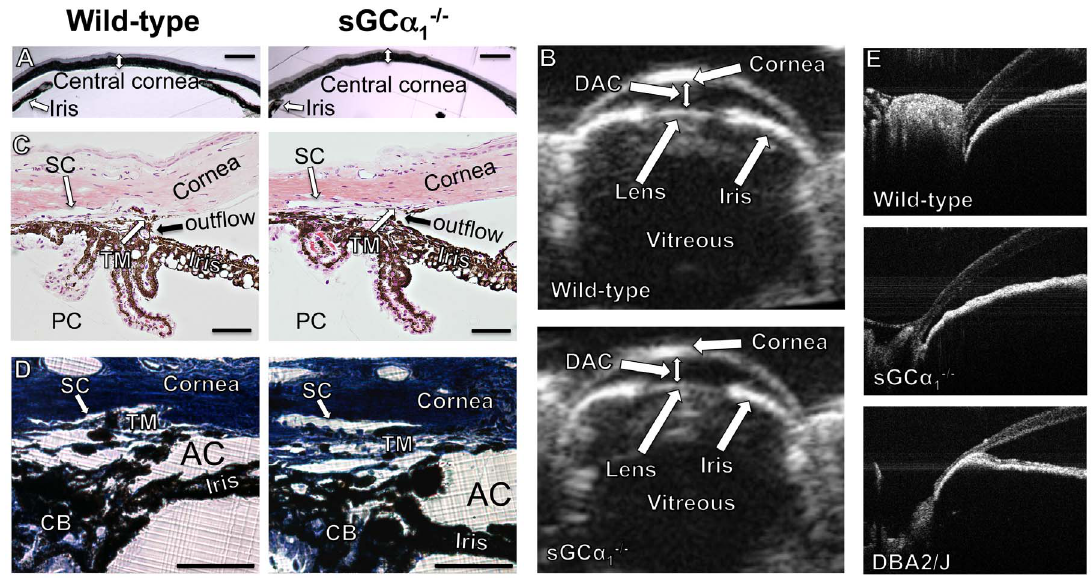
Figure 4. Morphology of the cornea and anterior segment does not differ in WT and sGC a 1 2 / 2 mice. A : Representative light microscopic images of the central cornea in wild-type (WT, left) and soluble guanylate cyclase a 1 -deficient mice (sGC a 1 2 / 2 , right). Central corneal thickness (CCT) was similar in age-matched WT and sGC a 1 2 / 2 mice. Double arrows: CCT. Scale bar: 200 m m. B : Representative ultrasound biomicroscopy images of the ocular anterior segment, obtained in WT ( upper panel ) and sGC a 1 2 / 2 mice ( lower panel ). The cornea, iris, vitreous, and lens are evident. Depth of the anterior chamber (DAC, double arrow) did not differ in WT and sGC a 1 2 / 2 mice. C and D : Representative light microscopic images of paraffin sections stained with hematoxylin and eosin (C, scale bar: 100 m m) or Toluidine Blue (D, scale bar: 50 m m) containing the iridocorneal angles of 12- month-old WT ( left panels ) and sGC a 1 2 / 2 mice ( right panels ). Location of the cornea, iris root, ciliary body (CB), anterior chamber (AC), and posterior chamber (PC) are indicated. E : Representative SD-OCT images of the ocular anterior segment, obtained in a 12-month-old wild-type mouse ( upper panel ), a 12-month-old sGC a 1 2 / 2 mouse ( middle panel ), and a 12-month-old DBA2/J mouse in which the angle is closed ( lower panel ). SD-OCT revealed no morphological abnormalities in sGC a 1 2 / 2 mice that would suggest a closed angle as detected in old DBA2/J mice. See also Movies S1, S2, S3.